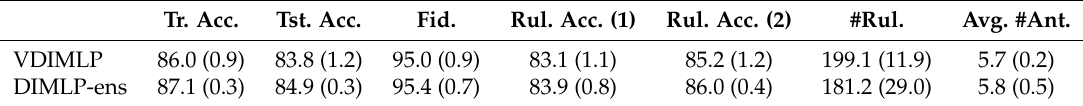
Table 7. Results obtained by transfer learning with a VGG network. The first row is related to VDIMLPs in the upper layers, while the second row concerns ensembles of DIMLPs replacing VDIMLPs. Tr. Acc. Tst. Acc. Fid. Rul. Acc. (1) #Rul. Avg.